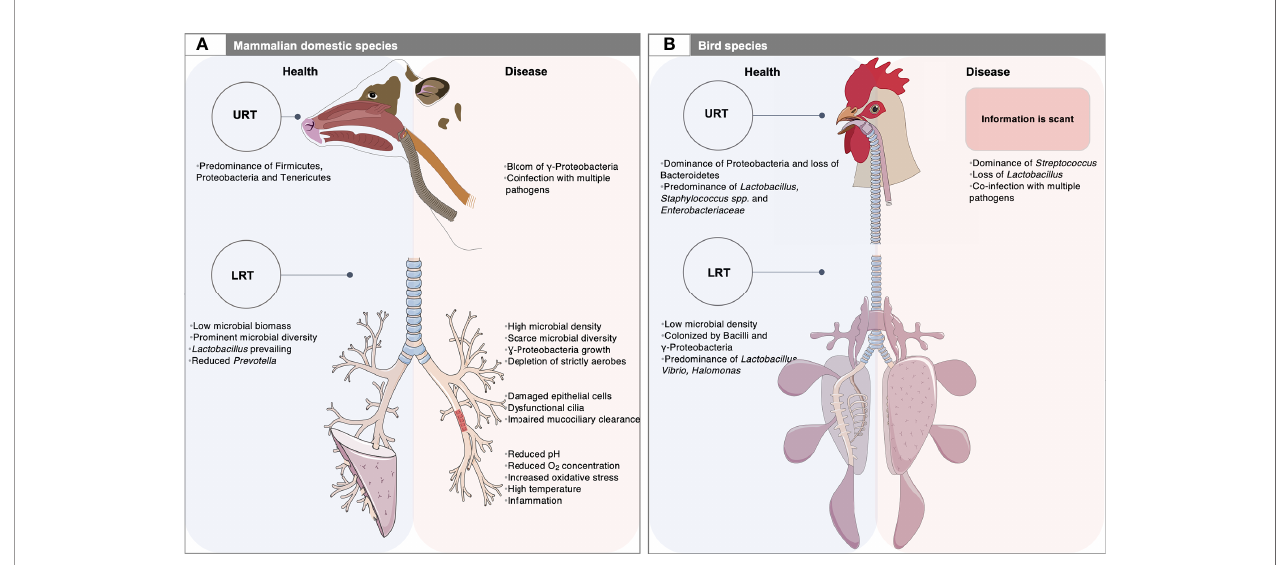
FIGURE 1 | Airway microbiota: a matter of animal species, physiology and diseased settings. (A) The respiratory tract of domestic mammals is mainly colonized by Firmicutes, Proteobacteria, Tenericutes and Bacteroidetes. At steady state (left, blue rectangle), the microbial biomass in the low respiratory tract (LRT) is low and likely depends on the balance between migration of bacteria from the upper respiratory tract (URT) and the mucociliary and immune clearance. During respiratory disease (right; red rectangle), the LRT bacterial propagation outpaces the capacity of the airways to clear the microorganisms, which often results in increased microbial density and dysbiosis. Dysfunctional cilia and enhanced mucus production may contribute to reduced clearance and trapping of microorganisms within airways. An outgrowth of g -Proteobacteria and loss of Firmicutes is observed in mammals, together with a limited microbial diversity, and the exacerbation of respiratory in fl ammation and loss of mucosal barrier function. In this context, co-infections by other pathogens or pathobionts are frequent. This polymicrobial disease involves microorganisms that act synergistically, or in succession to mediate complex disease processes. Studying such questions is challenging due to the complexity of sample collection. The exploration of LRT microbiota is based on invasive sampling techniques such as bronchoalveolar lavage, bronchus mucosal scraping and tracheal aspirates. Swaps of the deep nasal cavity, nasopharynx, oropharynx, paranasal sinus and tonsil are usually taken to explore the URT site; (B) The URT of birds is qualitatively similar to that of mammals. However, the nasal and oral cavities communicate with each other through the choanal cleft region. Their URT is mainly colonized by Firmicutes and Proteobacteria. At the genus level, a healthy ecosystem mainly includes highly dominant taxa, namely Lactobacillus, Staphylococcus spp. and members of the Enterobacteriaceae family. Unlike mammals, the LRT comprises the syrinx and the air sacs distributed throughout the body. In a stable state, the microbial density in the lung is very low. The LRT is mainly colonized by Bacilli and g -Proteobacteria. At the genus level, Lactobacillus is the dominant bacterial taxon, followed by Vibrio and Halomonas . Yet, information related to the microbiota composition under respiratory diseases is scant. The assessment of microbiota in the URT is based on choanal swabs, nasal cavity wash and upper and lower tracheal washes, whereas the description of the LRT microbiota depends on lower respiratory lavage. The picture of mammalian LRT was downloaded from smart Servier Medical Art https://smart.servier.com without changes. Servier Medical Art by Servier is licensed under a Creative Commons Attribution 3.0 License. Written permission for publication of the chicken fi gure and chicken respiratory system drawing has been